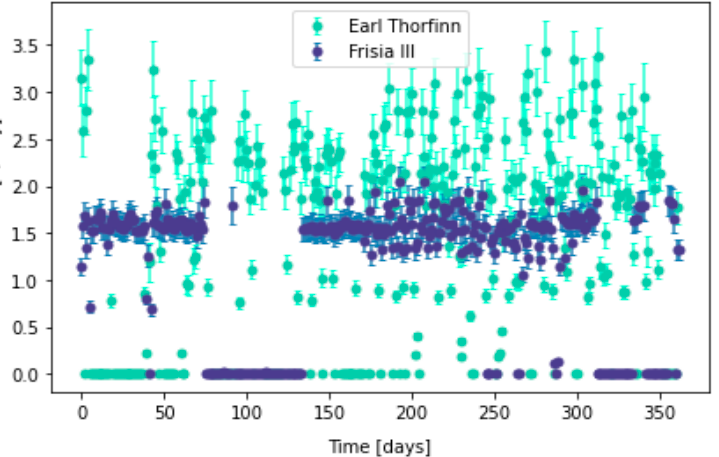
Figure 5. Fuel consumption, in tons per day, of the Earl Thorfinn and Frisia III in the year 2020 (Source: By author).